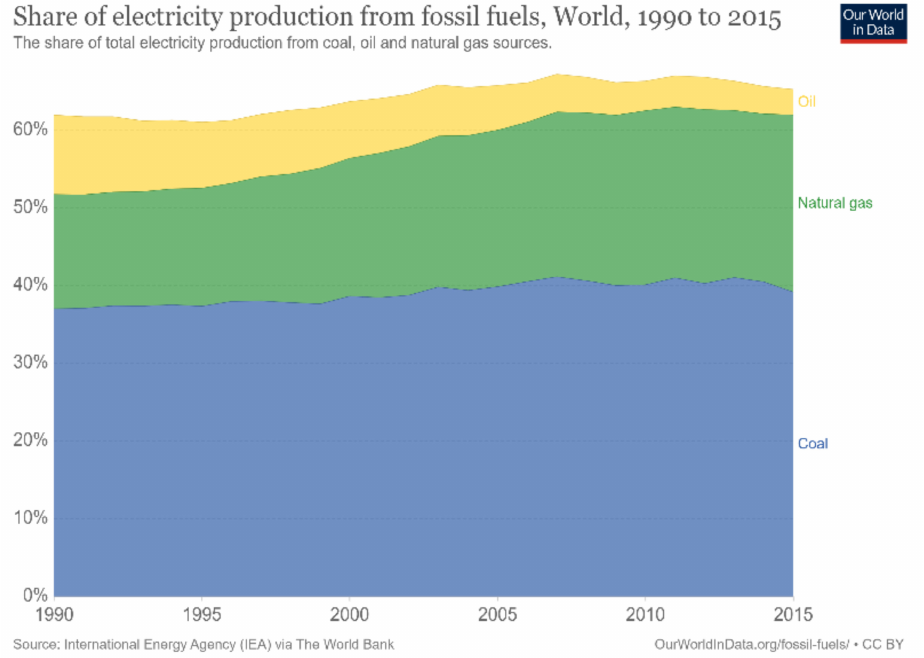
Figure 2. Share of electricity production from fossil fuels